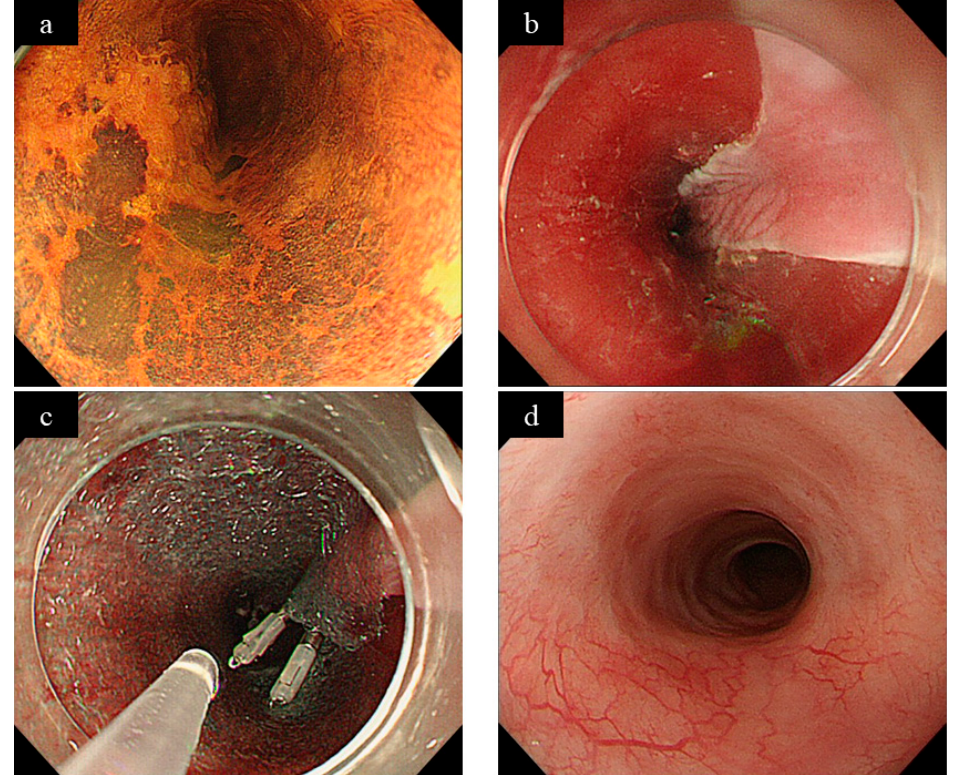
Figure 2. A case of polyglycolic acid (PGA) sheet application (courtesy of Dr. Ono of the University of Tokyo). ( a ) Squamous cell carcinoma of the middle thoracic esophagus with a circumference of more than 1/2. ( b ) Endoscopic submucosal dissection (ESD) was performed, resulting in an approximately 5/6 circumferential mucosal defect. ( c ) The PGA sheet was coated over the mucosal defect by the clip and pull method. ( d ) Six months after ESD. The mucosal defect was completely epithelialized, and no stricture occurred.